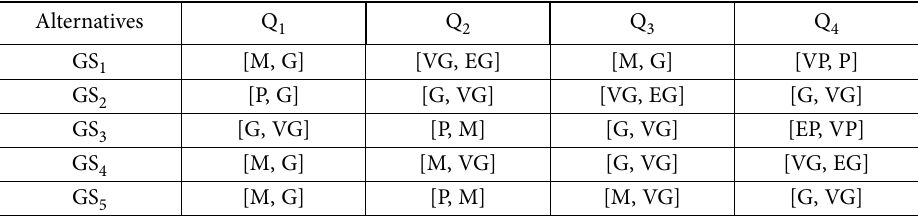
Table 5. The ULTSs through DM 5